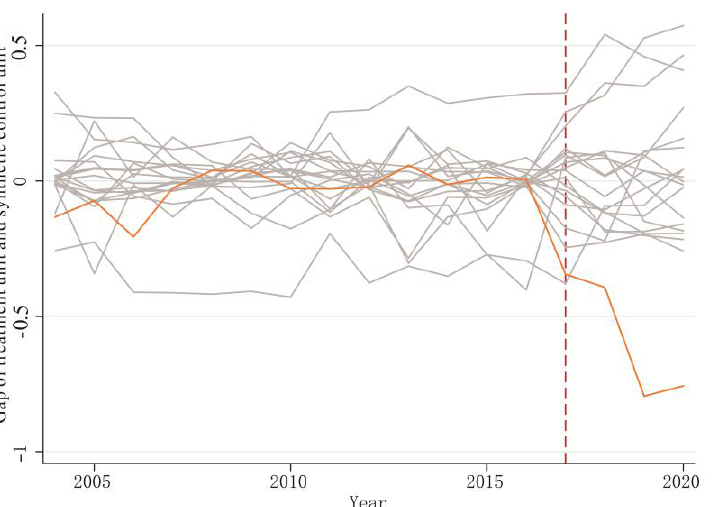
Figure 6. Industrial sulfur dioxide emission gaps in the black land area and placebo gaps in the control regions.